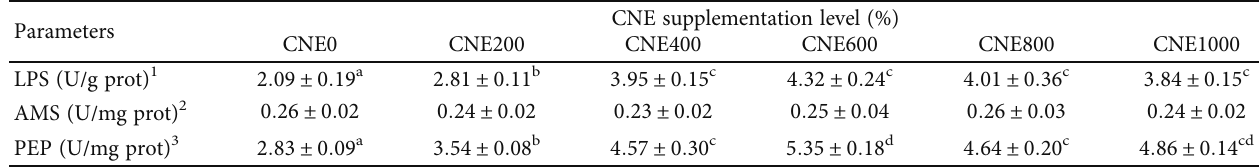
Table 5: Digest parameters of juvenile H . otakii fed the experimental diets for 8 weeks. Parameters